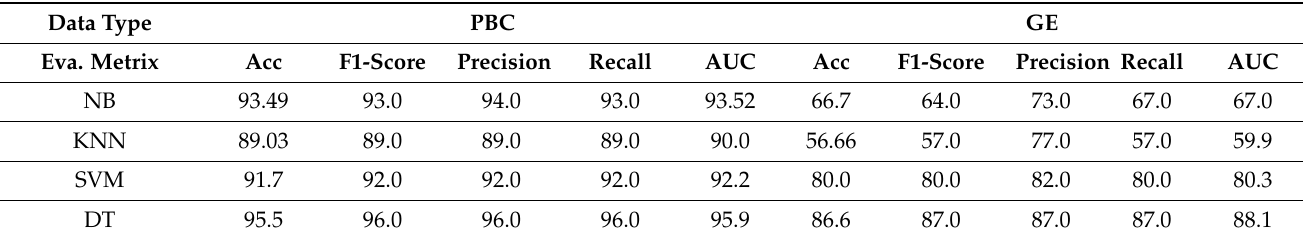
Table 5. First Experiment